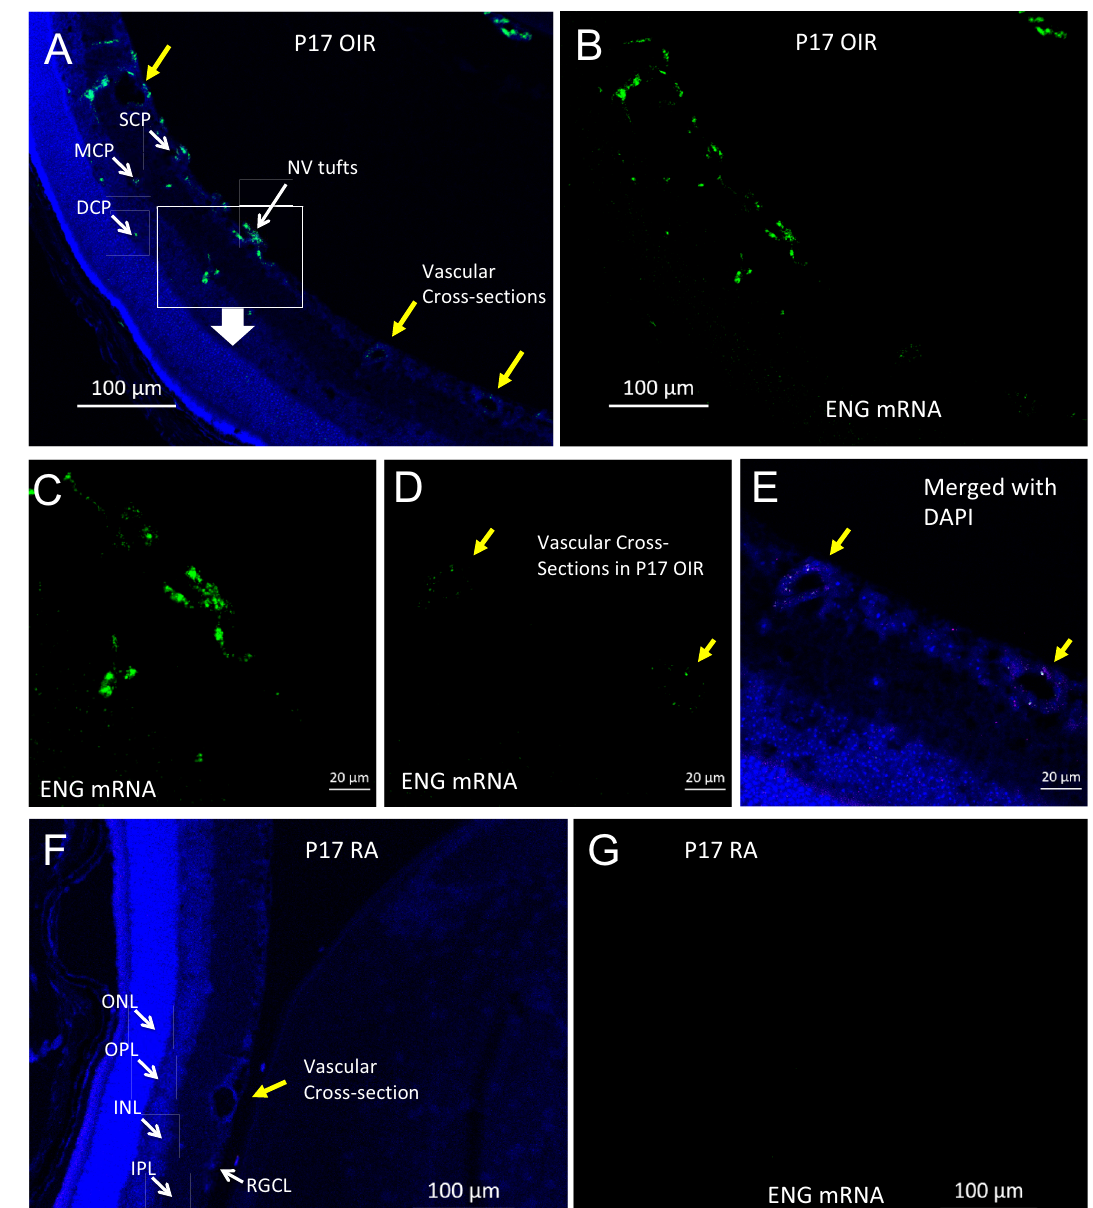
Figure 2. Fluorescence in situ hybridization (FISH) imaging to visualize endoglin (ENG) mRNA expression in transverse retinal sections from P17 OIR and P17 RA control mice. An intense green punctate, endoglin mRNA-dependent fluorescence is observed in OIR retinal cross section in cells around the vascular structures including superficial-, middle- and deep-capillary plexuses as shown in ( A , B ). DAPI staining was performed to identify the retinal layers. Scale bar 100 μm. ( C ) magnification view of the neovascularization (NV) in ( A ). ( D , E ) magnification view of the vascular cross-section (yellow arrows) shows minimal fluorescence in mature endothelial cells. Minimal fluorescence was observed in RA control retinas at P17 as shown in ( F , G ). SCP superficial capillary plexus, MCP middle capillary plexus, DCP deep capillary plexus), RGCL retinal ganglion cell layer, IPL inner plexiform layer, INL inner nuclear layer, OPL outer plexiform layer, ONL outer nuclear layer. Scale bar 20